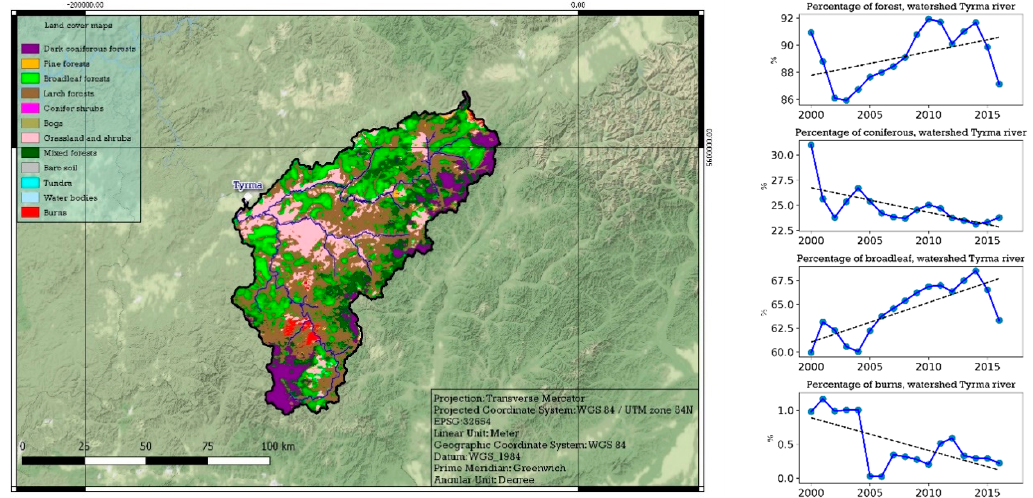
Figure 9. Vegetation dynamics of Tyrma River watershed. Stream gaging is marked with the white diamond.